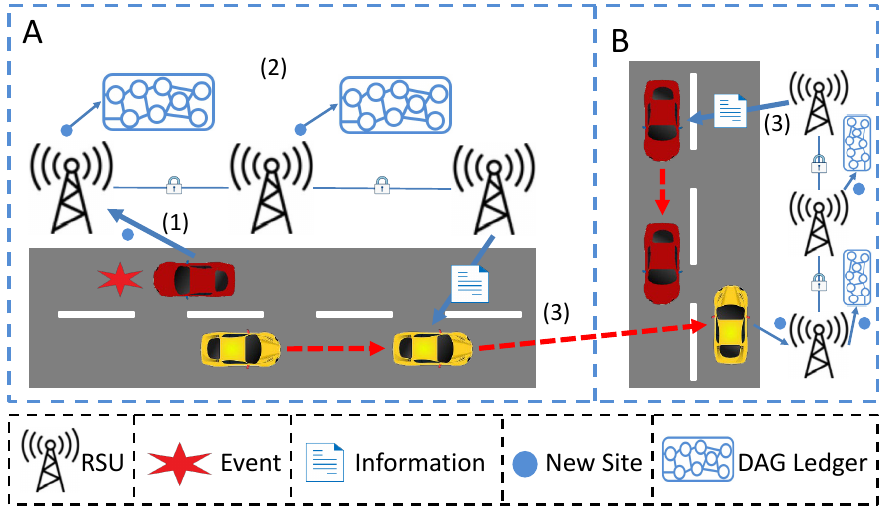
Figure 1. Information Sharing